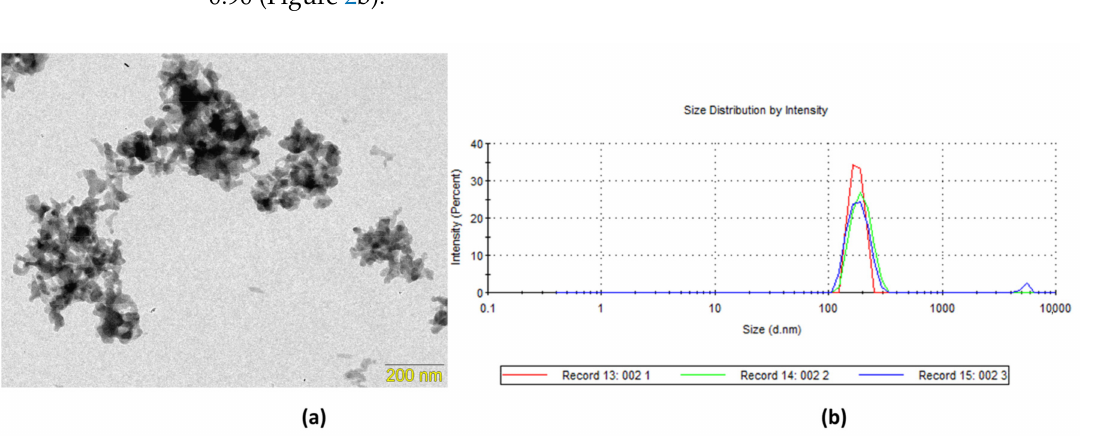
Figure 2. Sized and size distribution of the synthesized calcium-polyphosphate particles: ( a ) trans- mission electron microscopy (TEM); ( b ) dynamic light scattering (DLS).